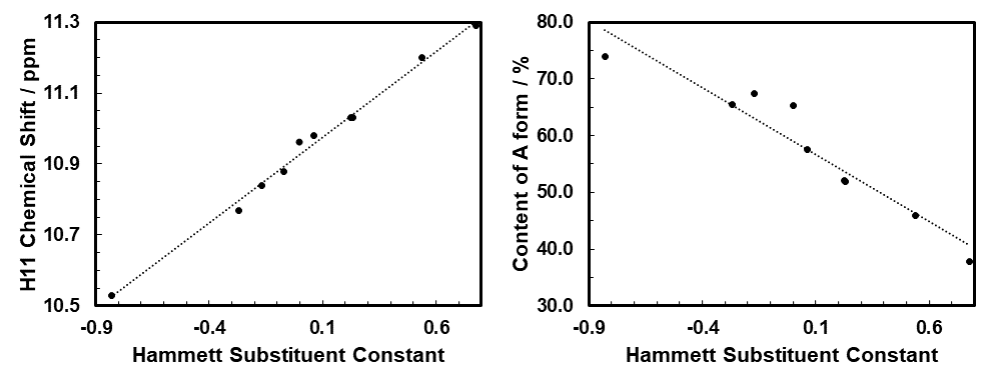
Figure 2. Correlation between the Hammett substituent constant and the 1 H NMR chemical shifts for H11 A form ( left , R 2 = 0.99) and content of A ( right panel, R 2 = 0.91).